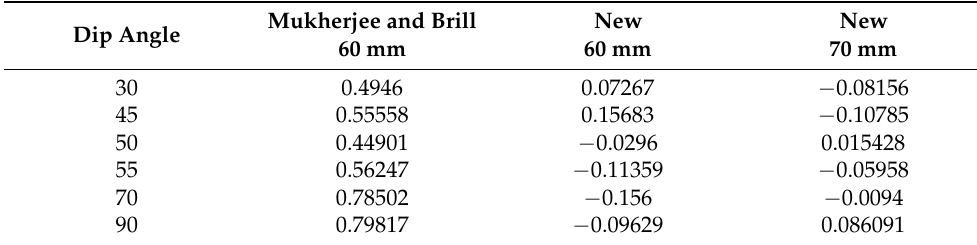
Table 3. Comparison of calculation error for the liquid holdup of the new model with that of the M– B model.